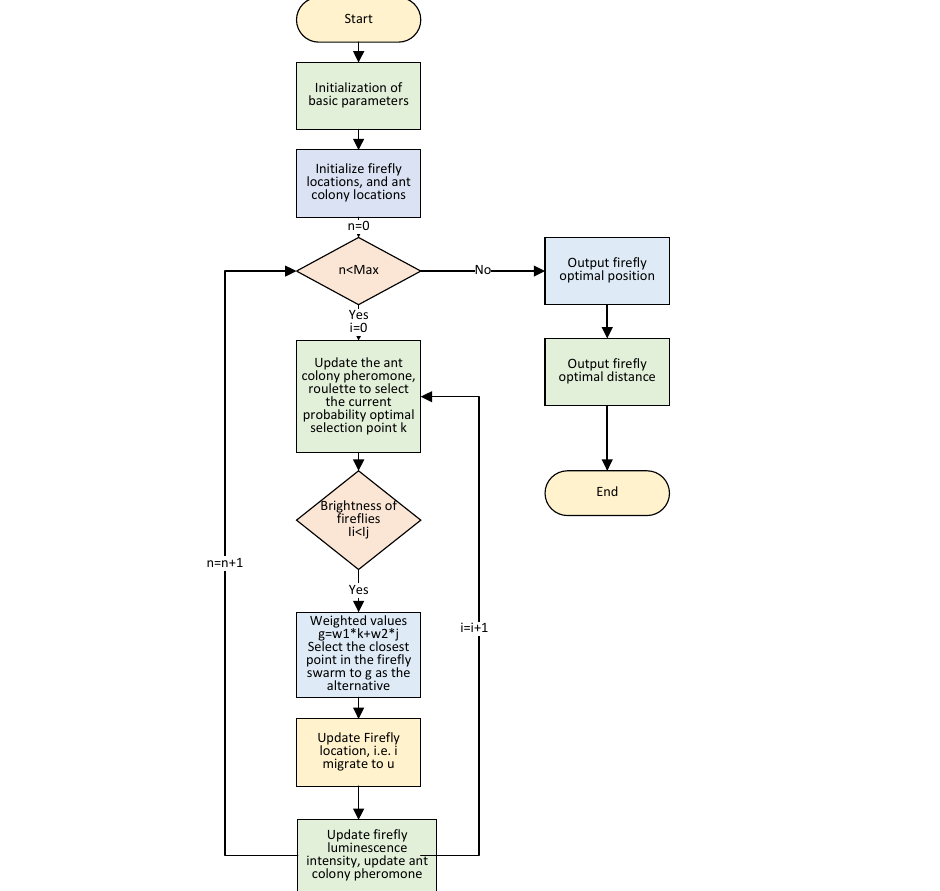
Figure 5. The flow chart of the